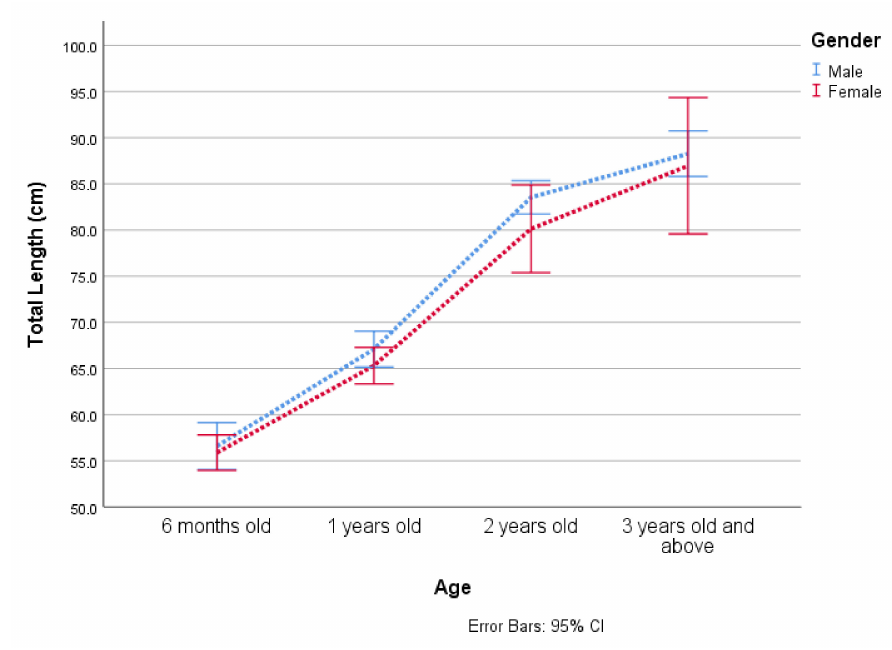
Figure 1. Age-wise total length growth of Chinese pangolins by gender.